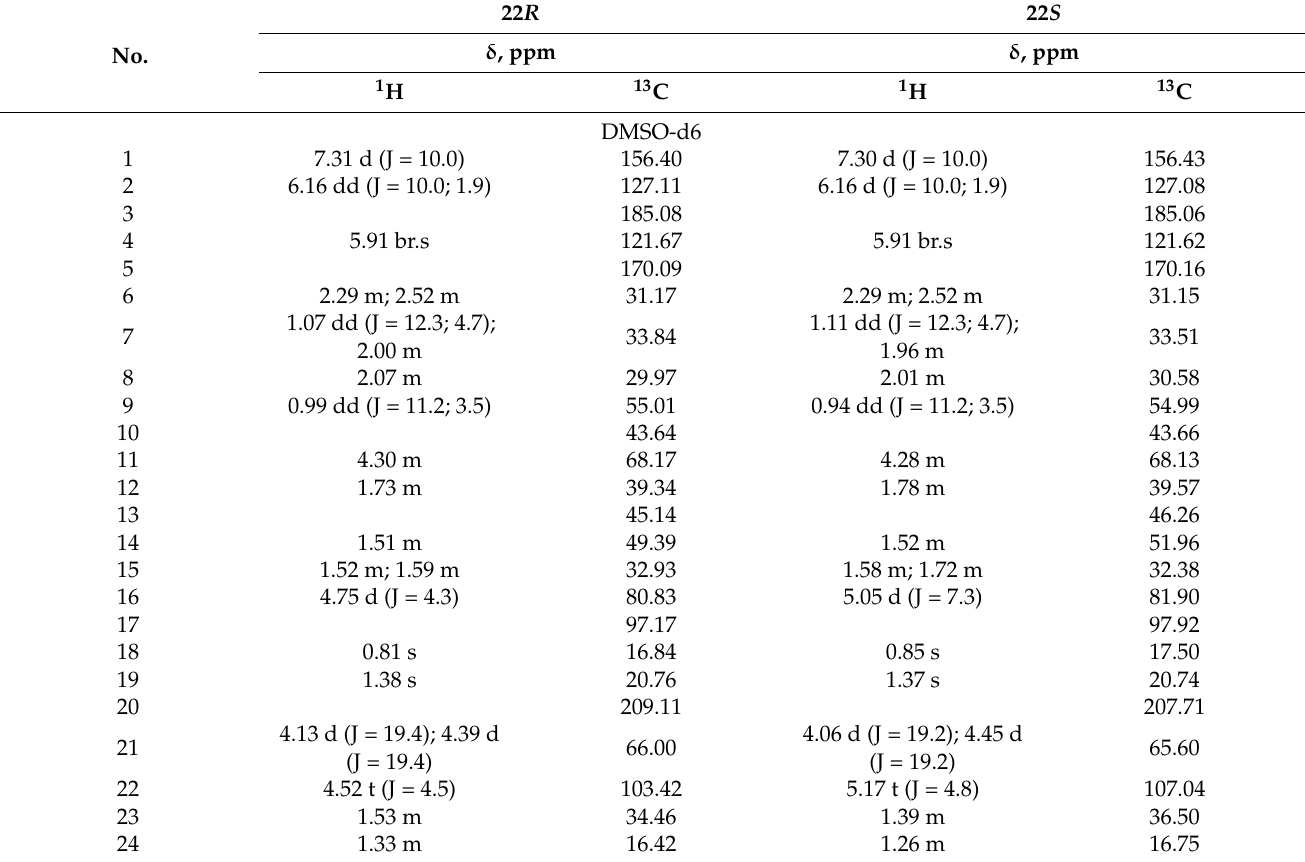
Table 1. Spectral characteristics of 22 R -Bud and 22 S -Bud.